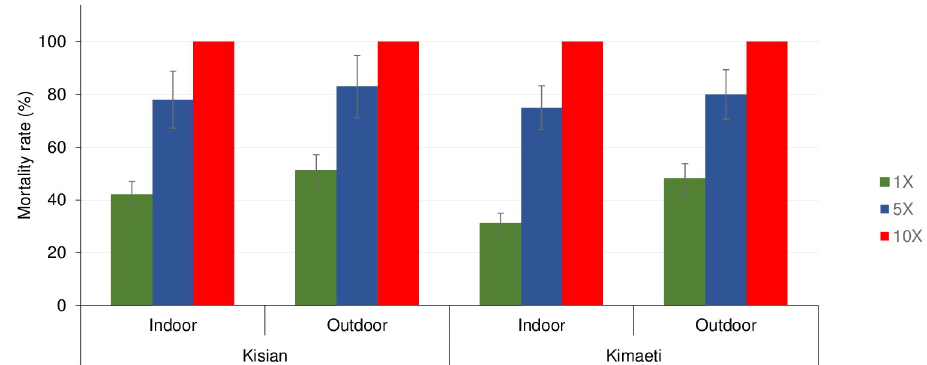
Fig 2. Mortality rates of An . gambiae s.l F1 progeny from indoor and outdoor resting collections recorded using CDC bottle intensity assays. Error bars indicate 95% confidence intervals. The 90% mortality threshold for declaring suspected resistance and 98% mortality threshold for calling full susceptibility based on the WHO criteria are